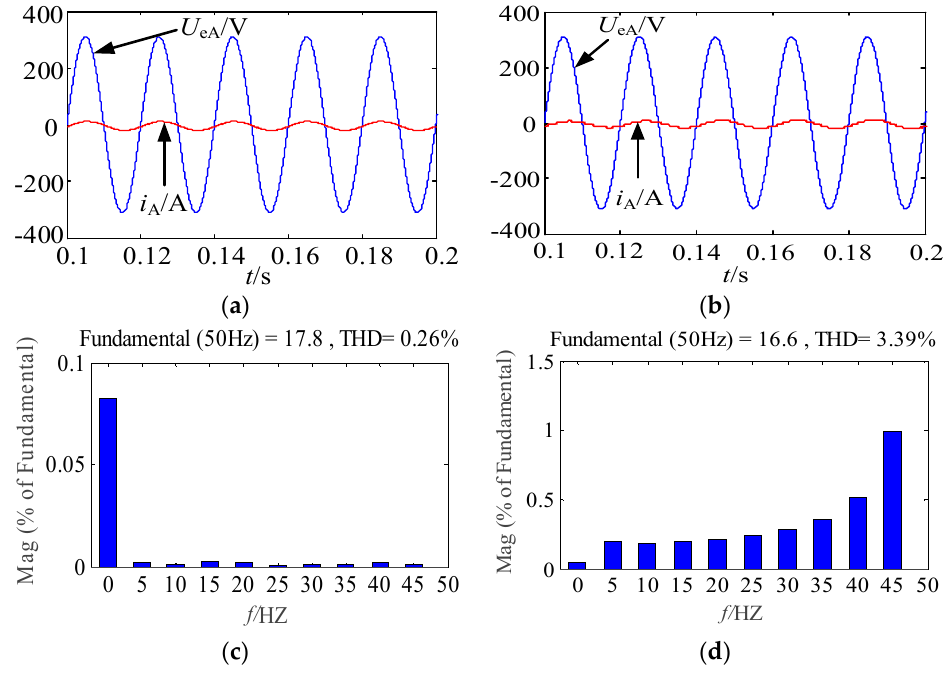
Figure 6. Comparison of phase and harmonics in two strategies; ( a ) A-phase grid voltage and current under a passivity-based control strategy; ( b ) A-phase grid voltage and current under the traditional PI control strategy; ( c ) A-phase current harmonics of the inverter under a passivity-based control strategy; and ( d ) A-phase current harmonics of the inverter under the traditional PI control strategy. Table 3. Comparison of the two control strategies.